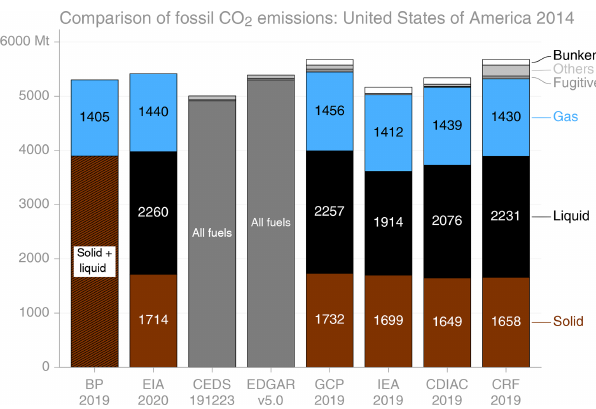
Figure 8. Comparison of CO 2 emissions estimates in the USA from eight datasets, 2014.